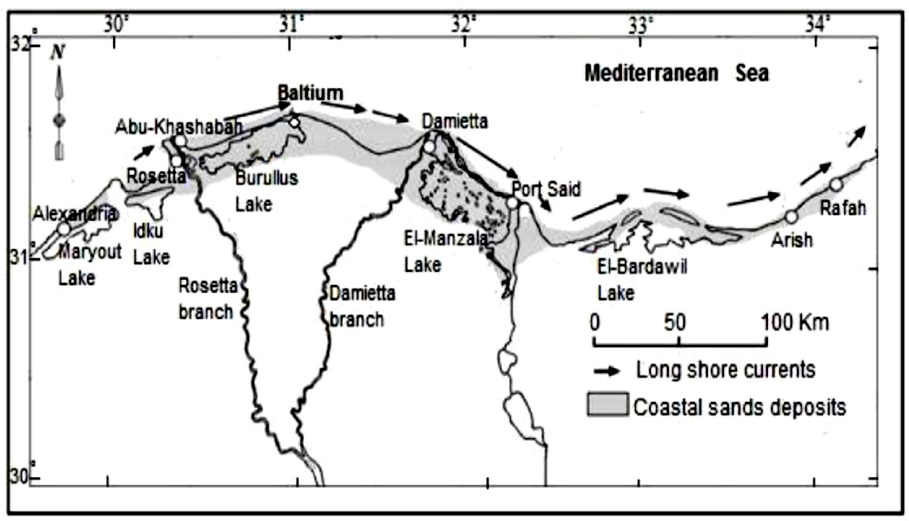
Figure 11. Distribution of the black sand deposits in the northern coastal zone of Egypt. In thin sections, zircon grains exhibit a color range from colorless to pale brown. They also exhibit a number of optical properties unique to the mineral. It shows itself as low pleochroism, high relief, acute extinction and considerable birefringence. Metamict Zircon has cracks and inclusions. It has been discovered that certain zircon grains are zonal and even twinned. Zircon forms in the tetragonal system and is optically positive.